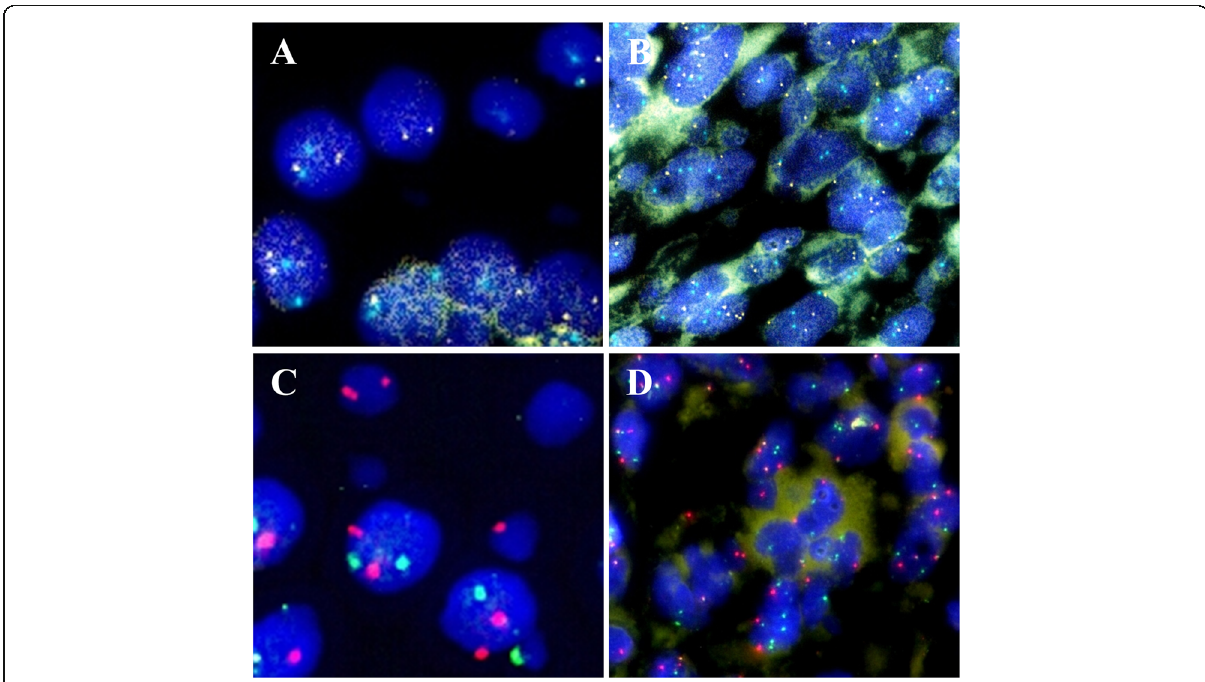
Fig. 4 FISH analysis with probes of chromosome 9p21 (gold), 17 (aqua), 3 (red) and 7 (green). a , c : Benign squamous cell epithelium, where one or two signals per one nucleus is observed for each probe. b , d : Sarcomatous component of the tumor, where varying copy number gains is observed with an increase in the copy numbers of chromosomes 9p21 ( CDKN2A , p16 gene), 3, 7, and